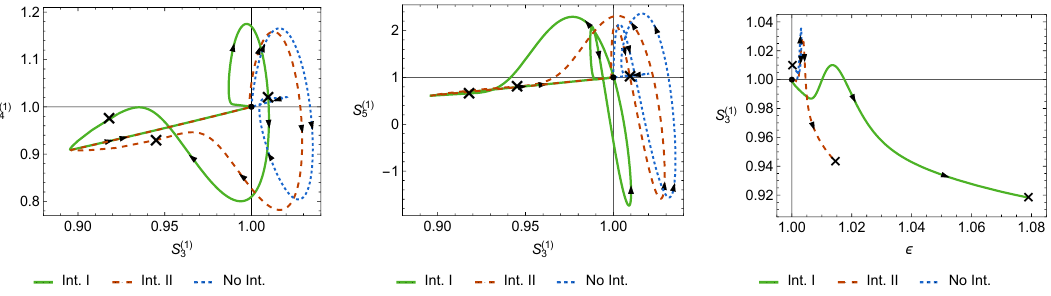
Figure 3. The evolution of statefinder Hierarchy { S 3 ( 1 ) , S 4 ( 1 ) } ( left panel ), { S 3 ( 1 ) , S 5 ( 1 ) } ( middle panel ) and the CDN { (cid:101) , S 3 ( 1 ) } ( right panel ) for the non-interacting 3-form dark energy (DE) model (dotted line), and when interactions I (full line) and II (dashed line) are turned on. The point { 1, 1 } indicates the Λ CDM model, the “ × ” symbols indicate the values of the statefinder parameters at the present time, and the arrows indicate the temporal